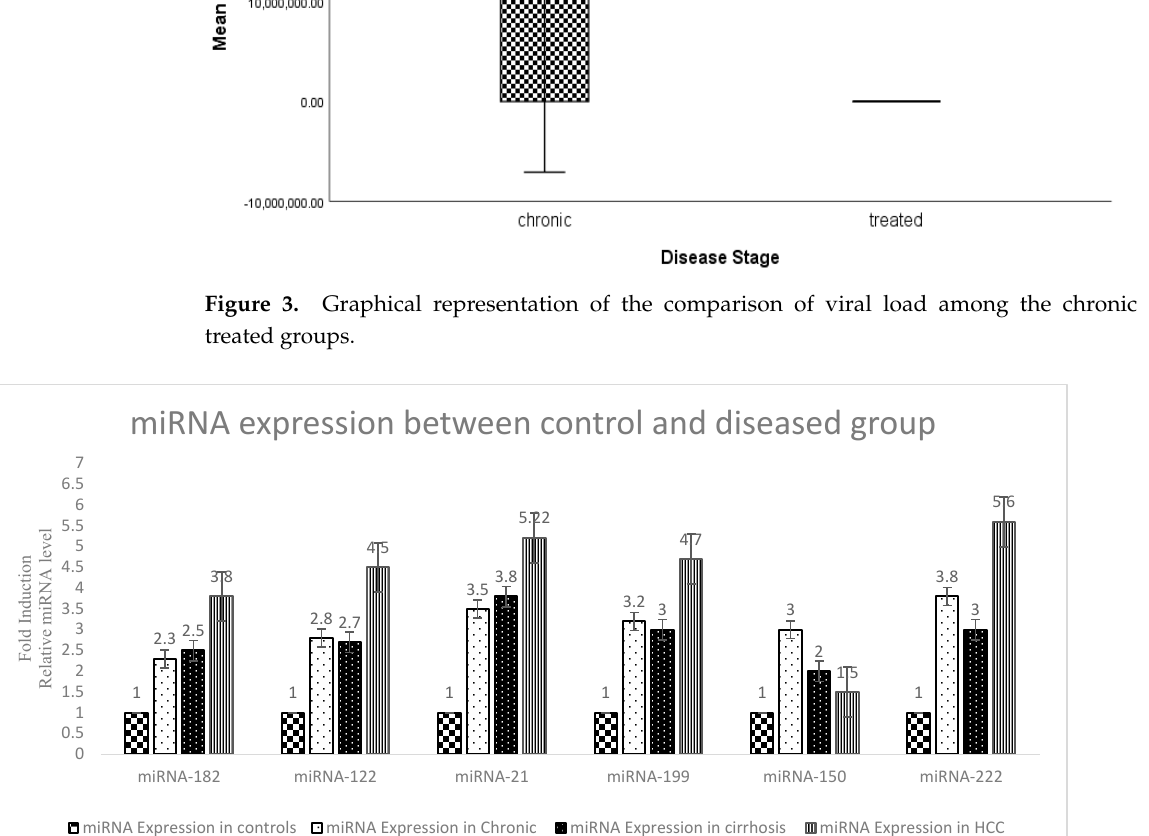
Figure 4. Graphical representation of expression analysis of miRNAs in diseased and control groups using real-time PCR .